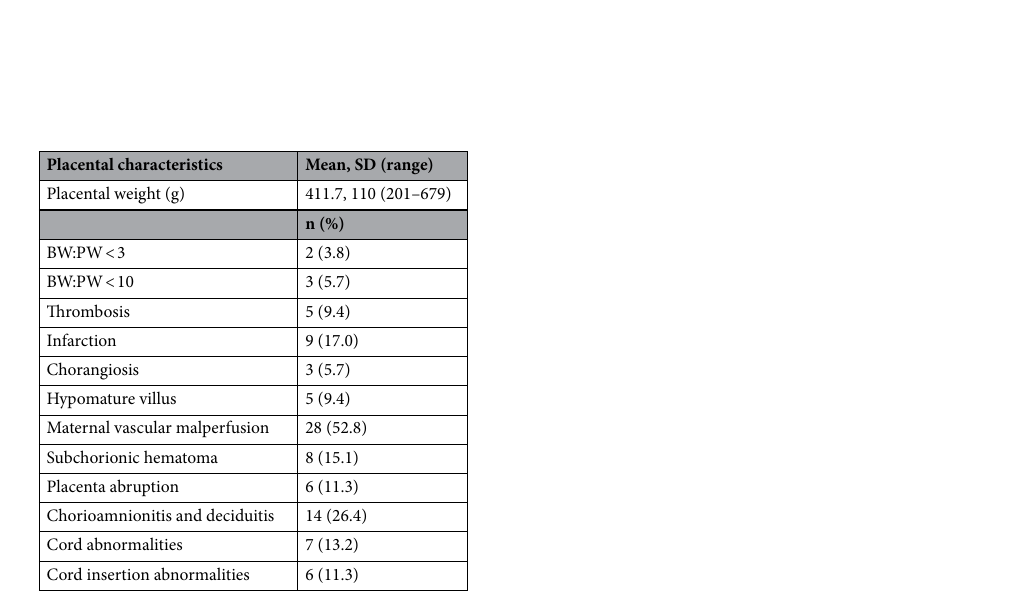
Table 3. Summary of abnormal placental findings seen on histopathological